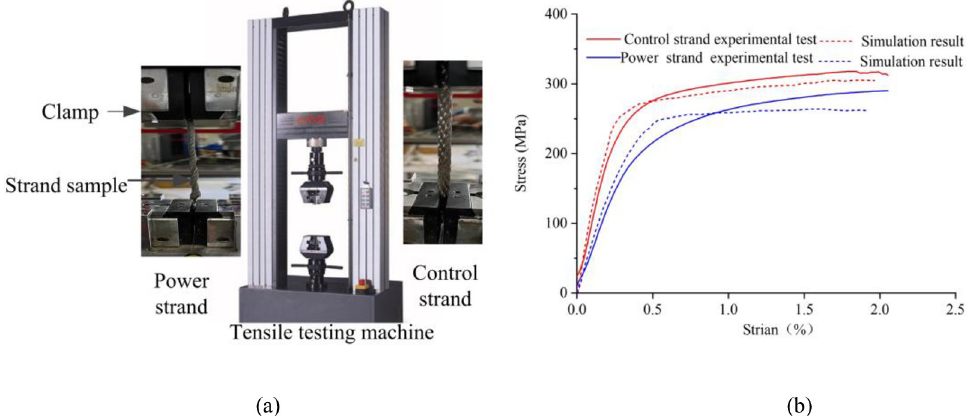
Fig 6. Tensile test: (a) test equipment; (b) stress-strain